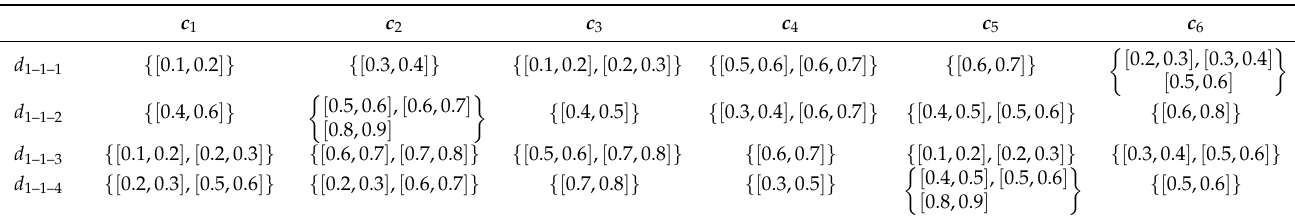
Table A1. Scoring matrix of financial structure analysis d 1–1 .